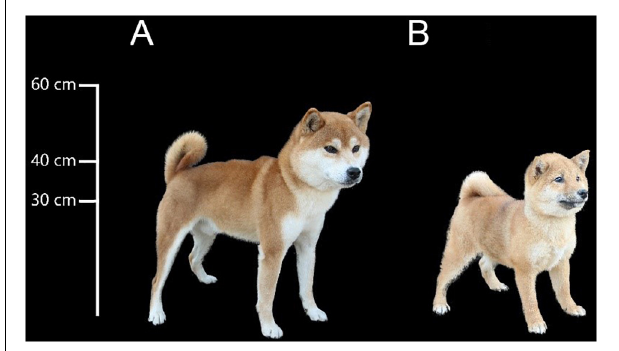
FIGURE 1 | Body sizes of Shiba Inu and Mame Shiba Inu. (A) Shiba Inu. (B) Mame Shiba Inu.